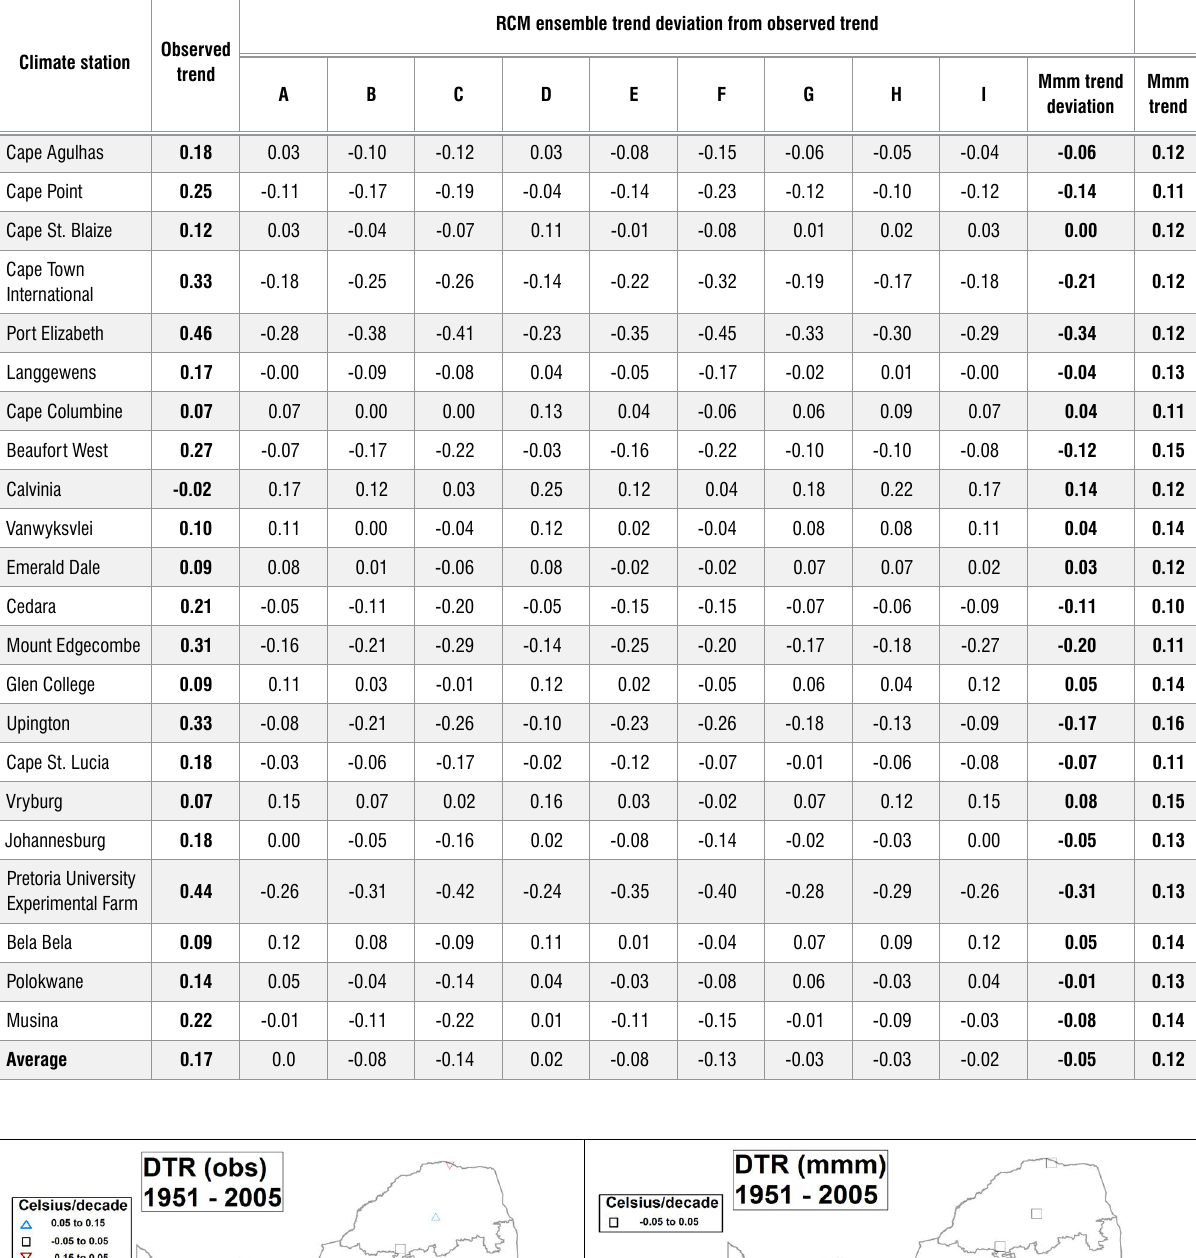
Observed trend of annual average minimum temperature (°C), as well as trend deviations of each one of the nine regional climate model (RCM) ensemble members (A–I as in indicated in Table 2) from the observed trend. The mmm trend and trend deviation are also given. Trends (°C/ decade) were calculated over the period 1951–2005.